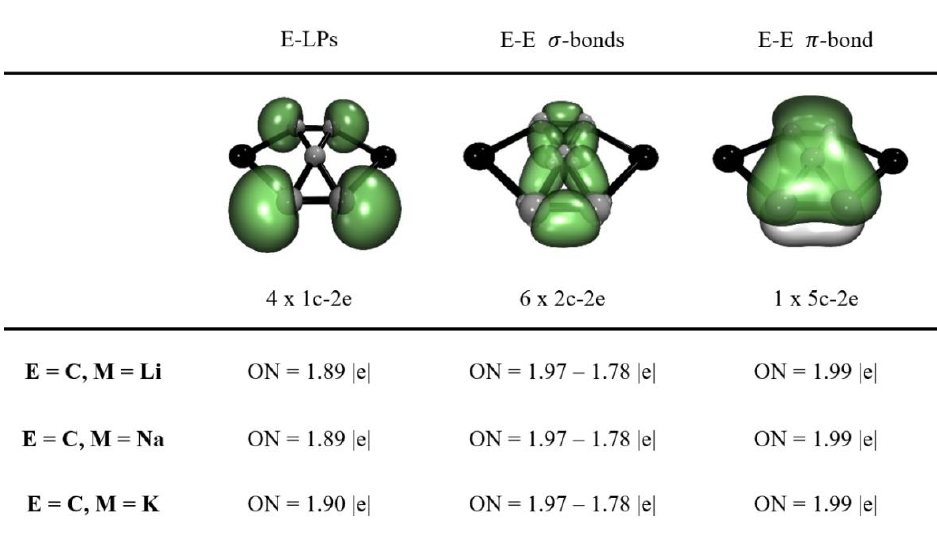
Figure 1. Adaptive Natural Density Partitioning bonding pattern of the M 2 C 5 (M=Li, Na, K) at the ωb97XD/Def2 -TZVP level.